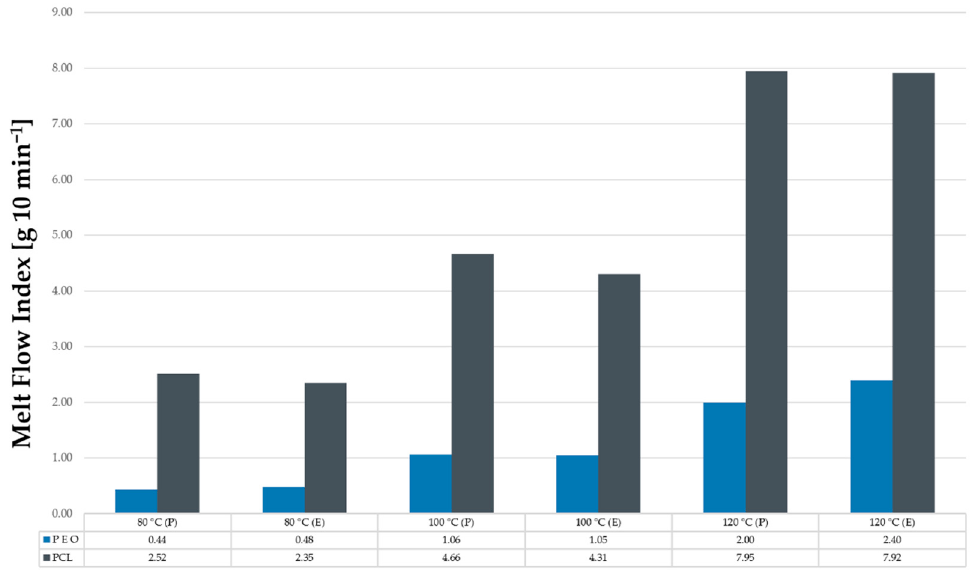
Figure 5 . Melt flow index readings for P = powder and E = extrudate of PEO and PCL at 80, 100 and 120 °C.